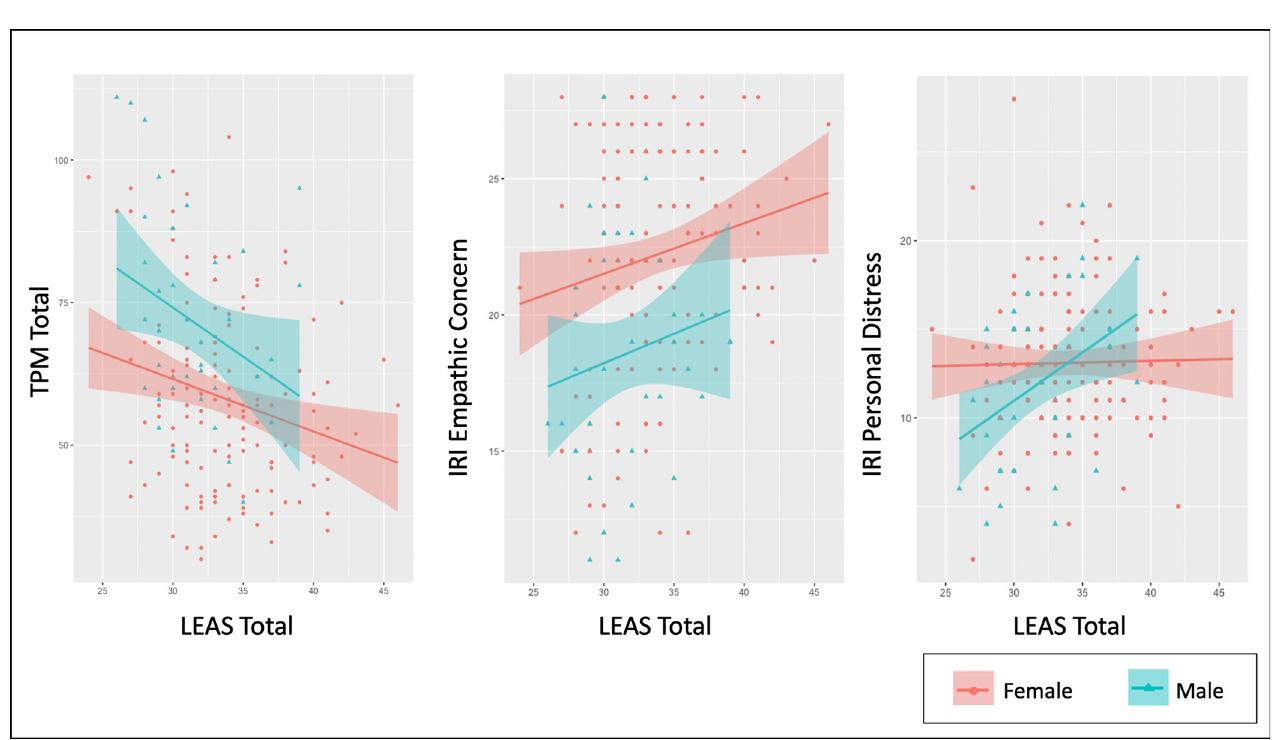
Fig 1. Relationships between emotional awareness, psychopathy, and empathy measures. This figure shows correlations between Levels of Emotional Awareness (LEAS) Total scores and both Triarchic Psychopathy Measure (TPM) Total scores and Interpersonal Reactivity Index (IRI) Empathic Concern and Personal Distress scores, separated by